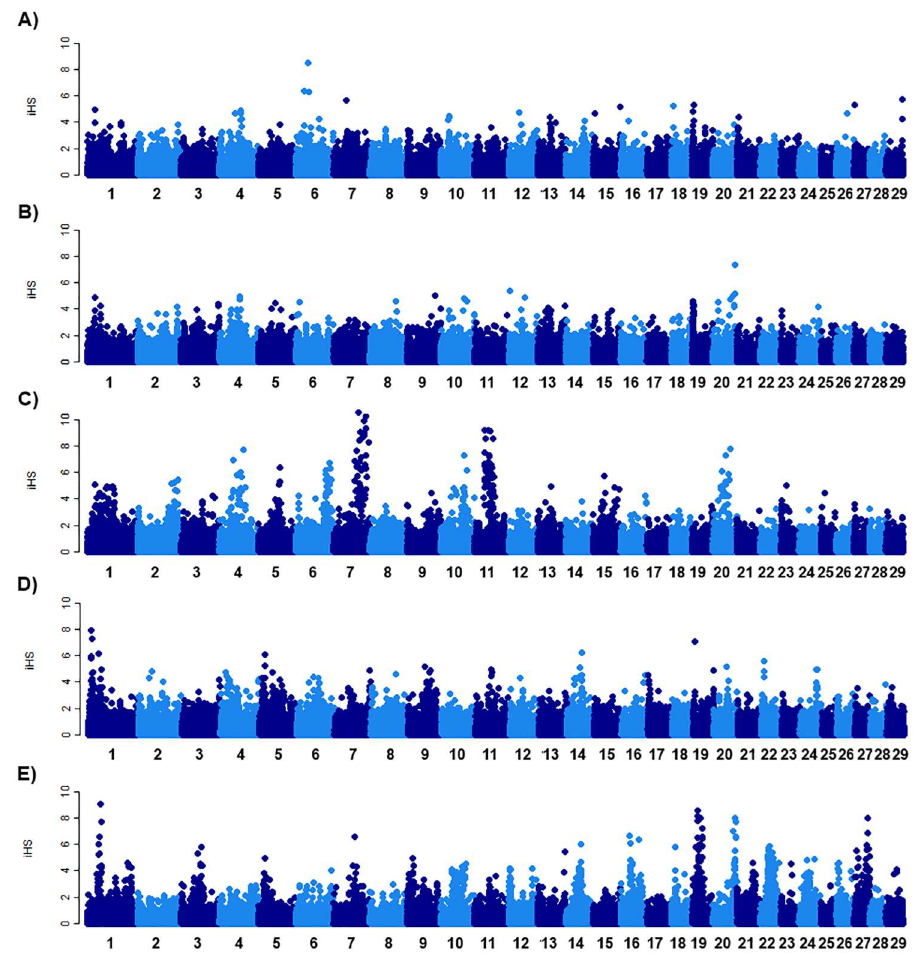
Fig 4. Signatures of selection (iHS) in the Tanzanian TSZ cattle population and two breeds. A: Sukuma B. Tarime C. Maasai D. Boran E.